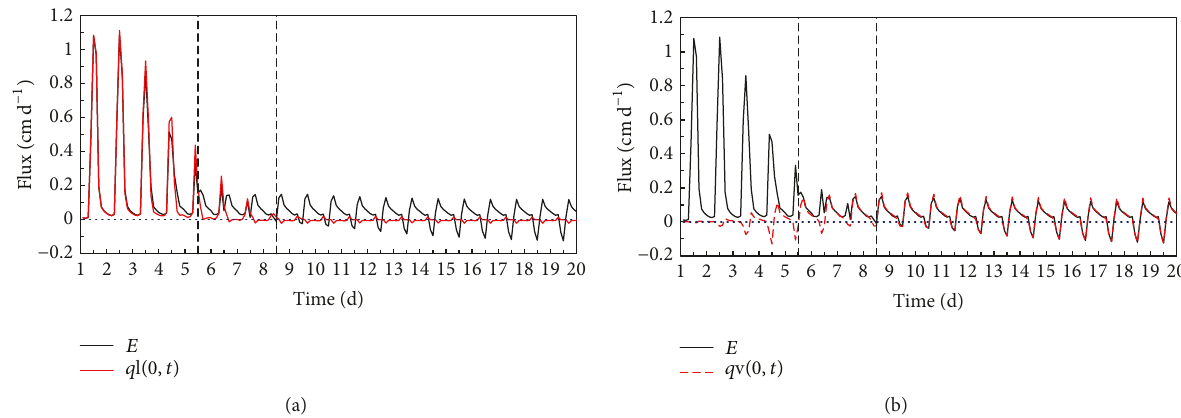
Figure 2: The liquid water (red solid line), water vapor (red dashed line) water fluxes, and the total flux (black solid line) at the soil surface. The left vertical dashed lines represent timing point of shift of evaporation process from stages 1 and 2, and periods between the two dashed line indicate the transient stage of evaporation process (same